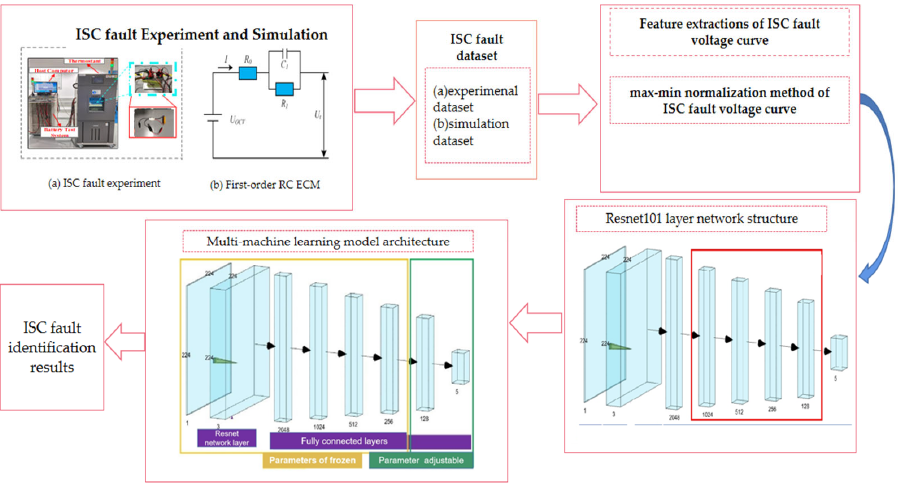
Figure 5. The architecture diagram of the ISC fault identification method based on the multi-machine learning fusion model.